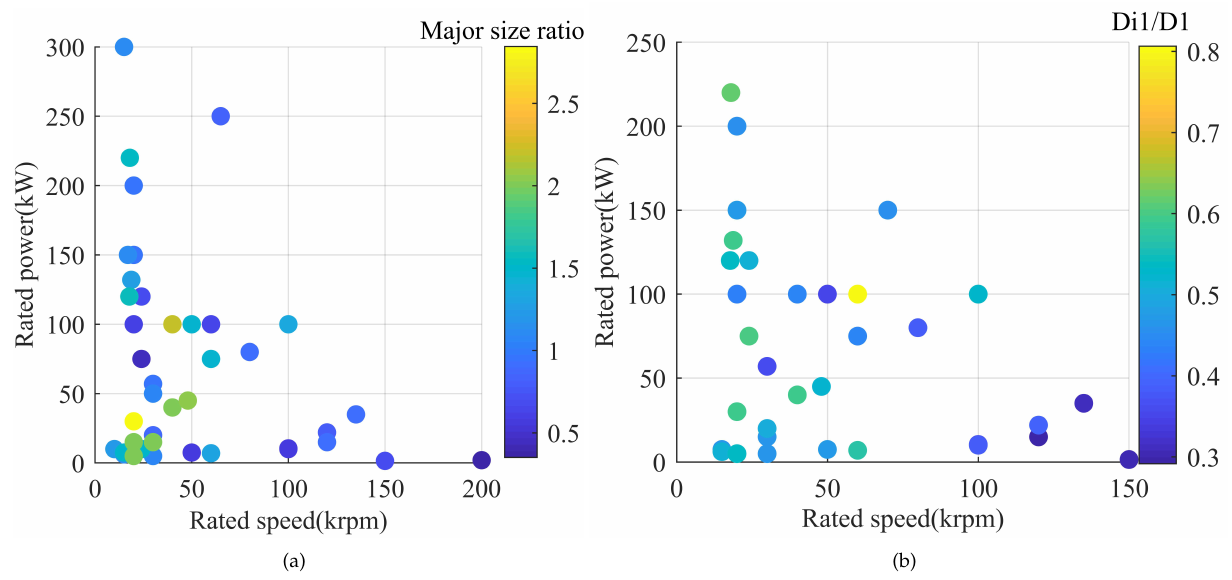
Figure 5. λ and D i 1 / D 1 distribution: ( a ) Distribution of λ of high-speed PM motors; ( b ) Distribution of D i 1 / D 1 of high-speed PM motors.